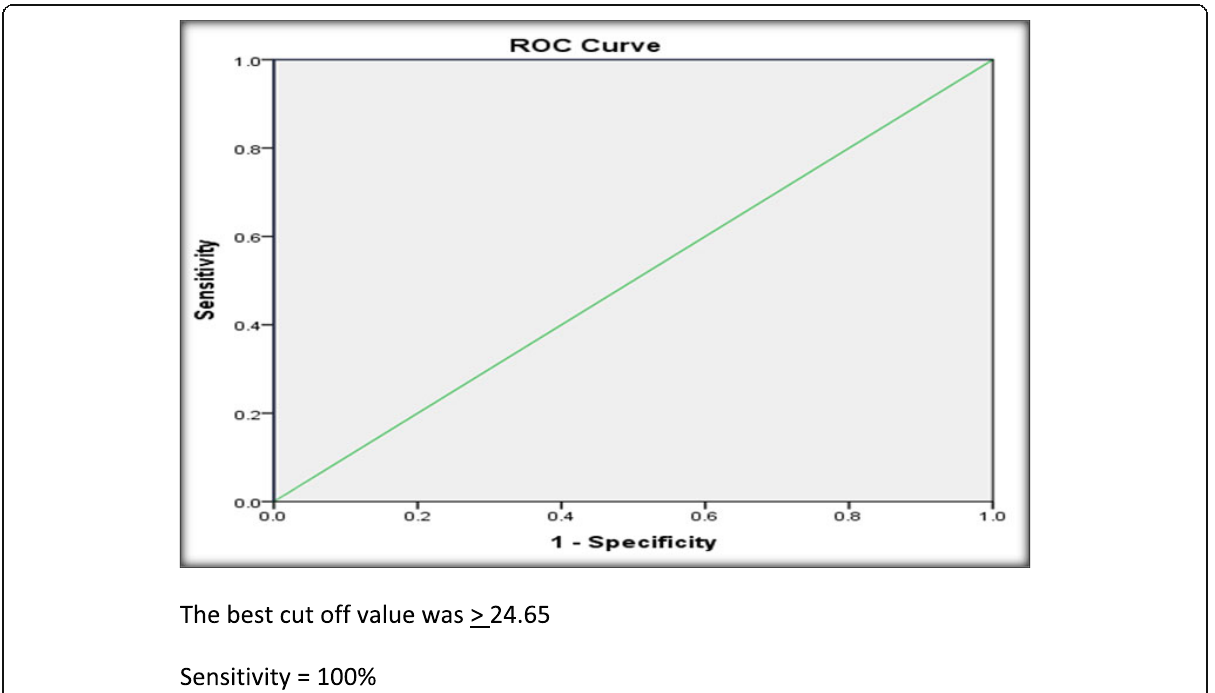
Fig. 1 Validity of LS measurement in prediction of recurrence after 1 year. The best cutoff value was ≥ 24.65, sensitivity = 100%, and specificity = 100%